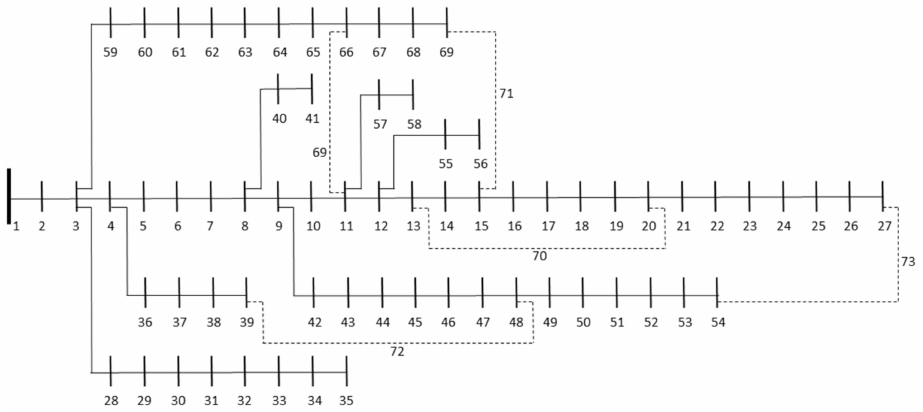
Figure 1. IEEE 69-bus test system.